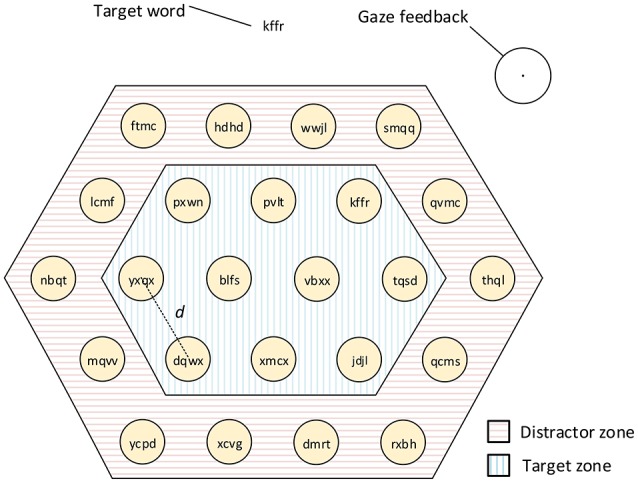
Design of the experimental task. The user has to look for the goal word displayed at the top of the screen, then, the user has to select the target with the exact same word. The detected gaze position is displayed under the form of a circle and a central point (visual feedback). For all trials the size of the targets remained constant, and only the length of the target word and the separation (d) between targets varied. The targets at the outer circle were distractors in which the target word was never placed.